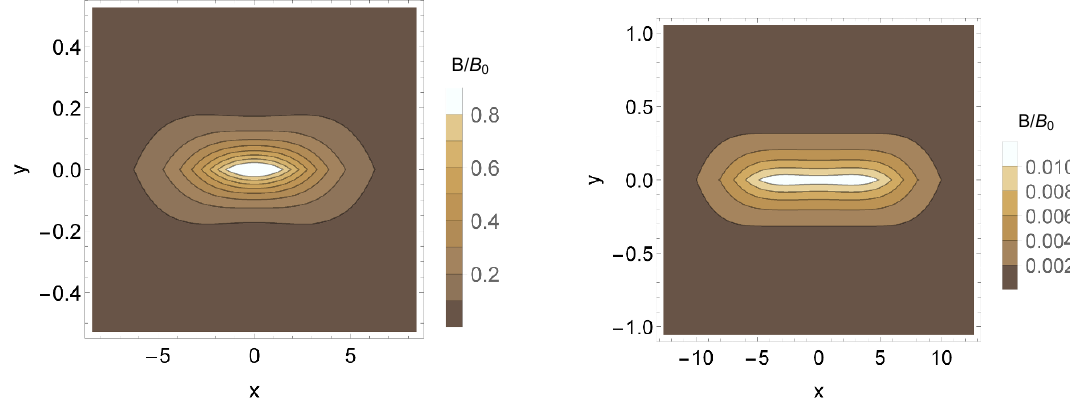
Figure 6 . (color online). The magnitude of the regularized magnetic (cid:12)eld in the transverse plane using parameters (cid:12)xed in (6.7) for ! 1 = 0 : 5 ; ! 2 = 0 : 05 at (a) (cid:28) = 0 : 4 fm = c, and (b) (cid:28) = 5 fm = c.